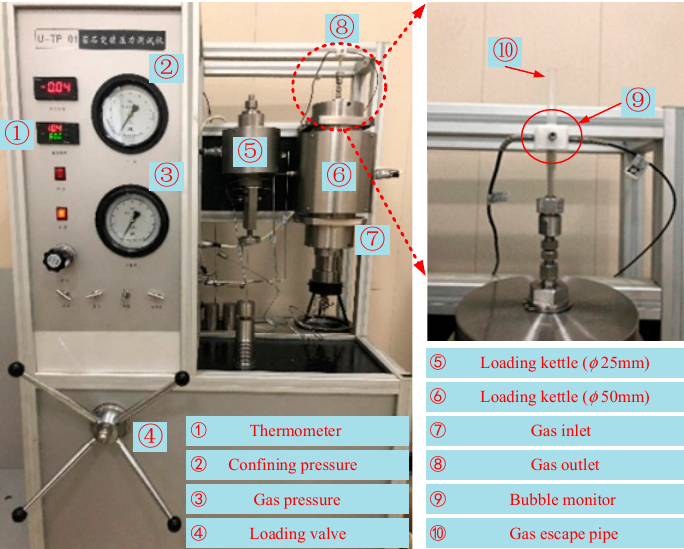
Figure 9. Breakthrough pressure of caprock test equipment (U-TP-01).